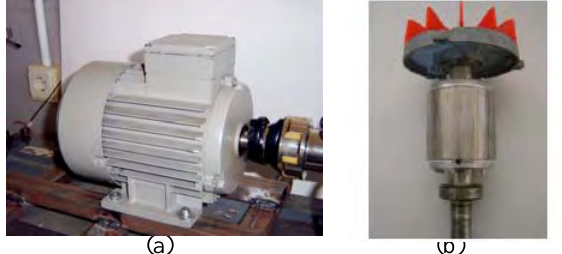
Fig. 6. (a) 1.1 kW motor under test (b) Rotor with one broken bar.